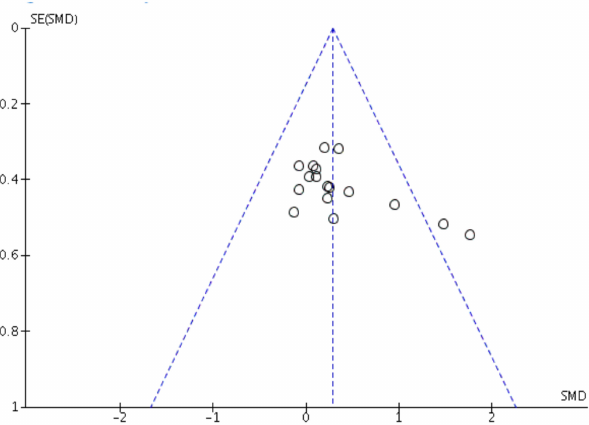
Figure 1. Funnel plot of standard error of sports performance test data by Hedges’